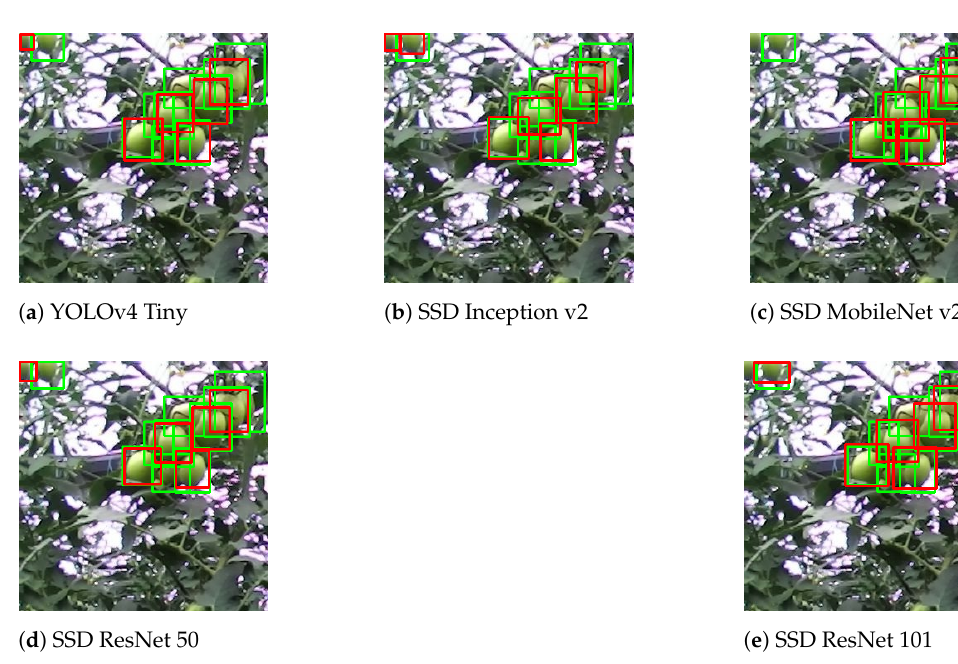
Figure 15. Result comparison for occluded tomatoes.